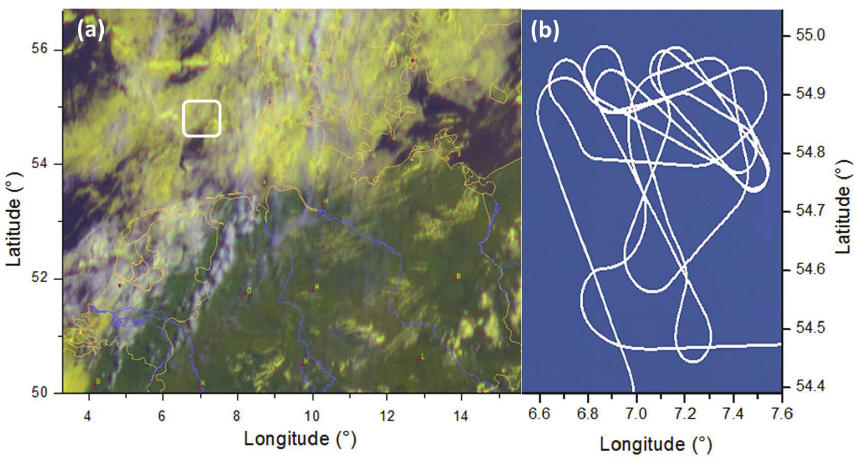
Figure 4. (a) Composite satellite image of the cloud situation on 30 August 2013 at 09:45UTC showing high-level cirrus (white) above low-level water clouds (yellow, Deutscher Wetterdienst/EUMETSAT). In (b) the flight track of the measuring flight in the restricted area (white box in (a) ) above the North Sea near the island of Helgoland, north Germany, is shown.